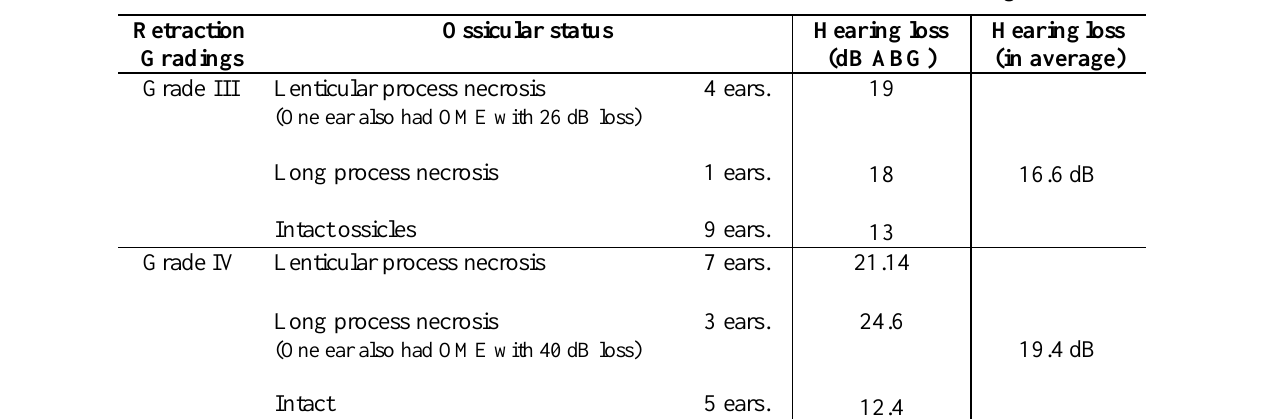
Table I : Grades of retraction in relation to the ossicular status and hearing